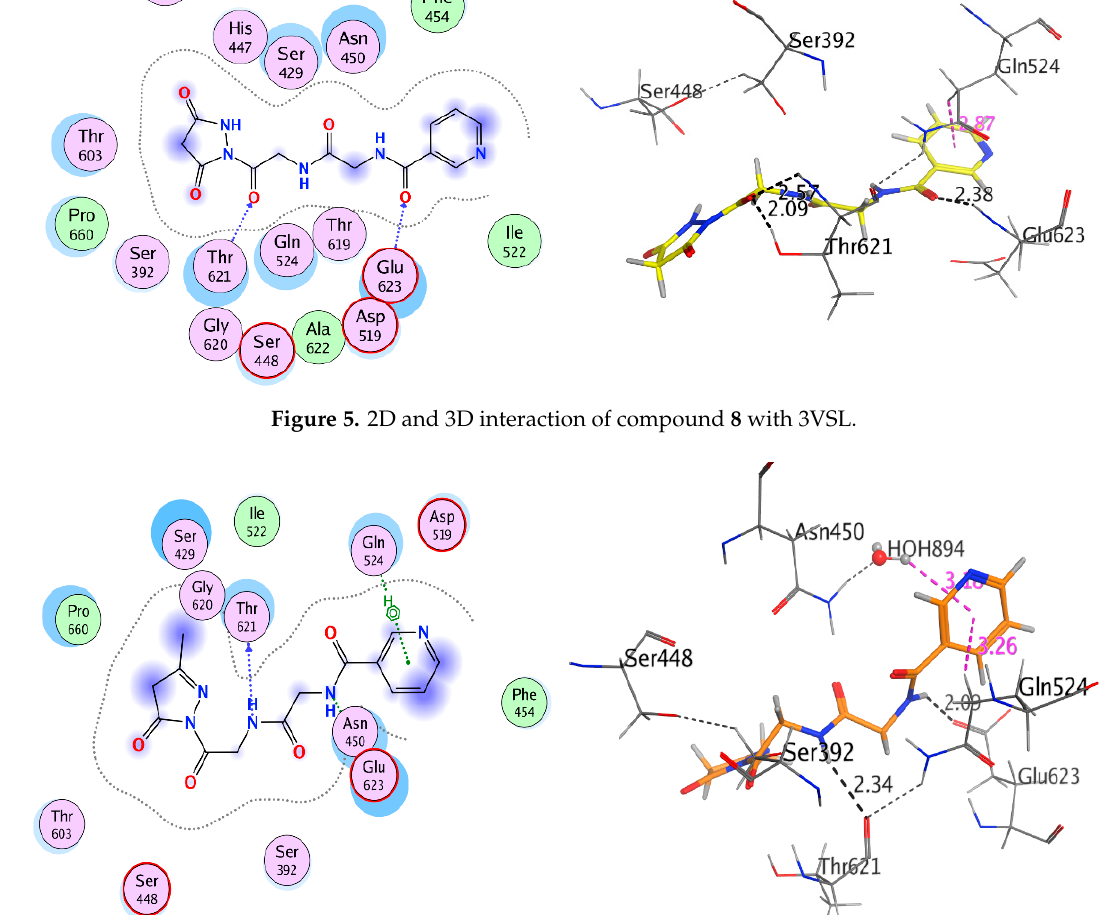
Table 3. Predicted binding-free energies ( Δ Gbind) for ligands 4–11 .